Question: Express in one sentence what the figure is showing.
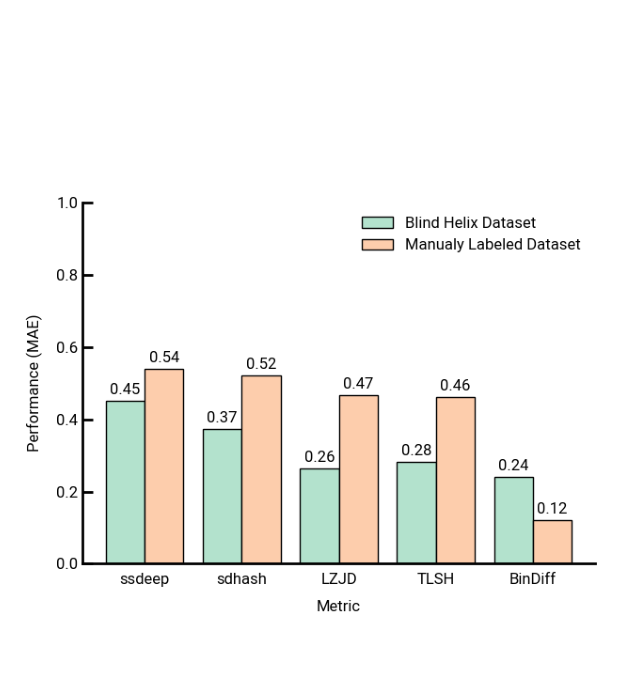
Answer: Program similarity metric performance on the Blind HELIX and manually-labeled datasets - lower is better.